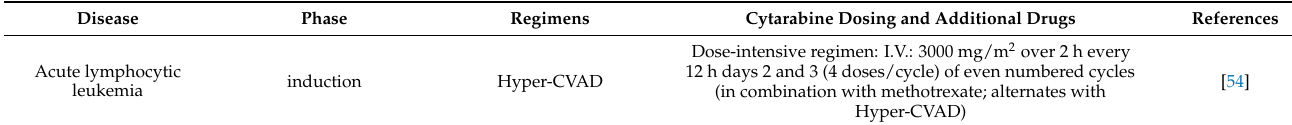
Table 2. Overview of cytarabine regimens including cytarabine for lymphoid neoplasms in adults. Details concerning doses in combination regimens should also be